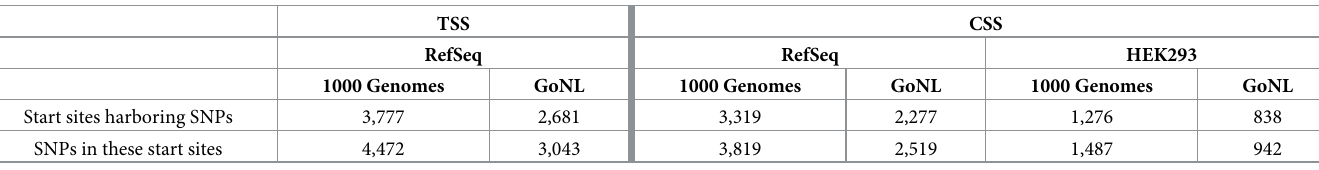
Table 1. Number of start sites and SNPs in direct vicinity of TSS and